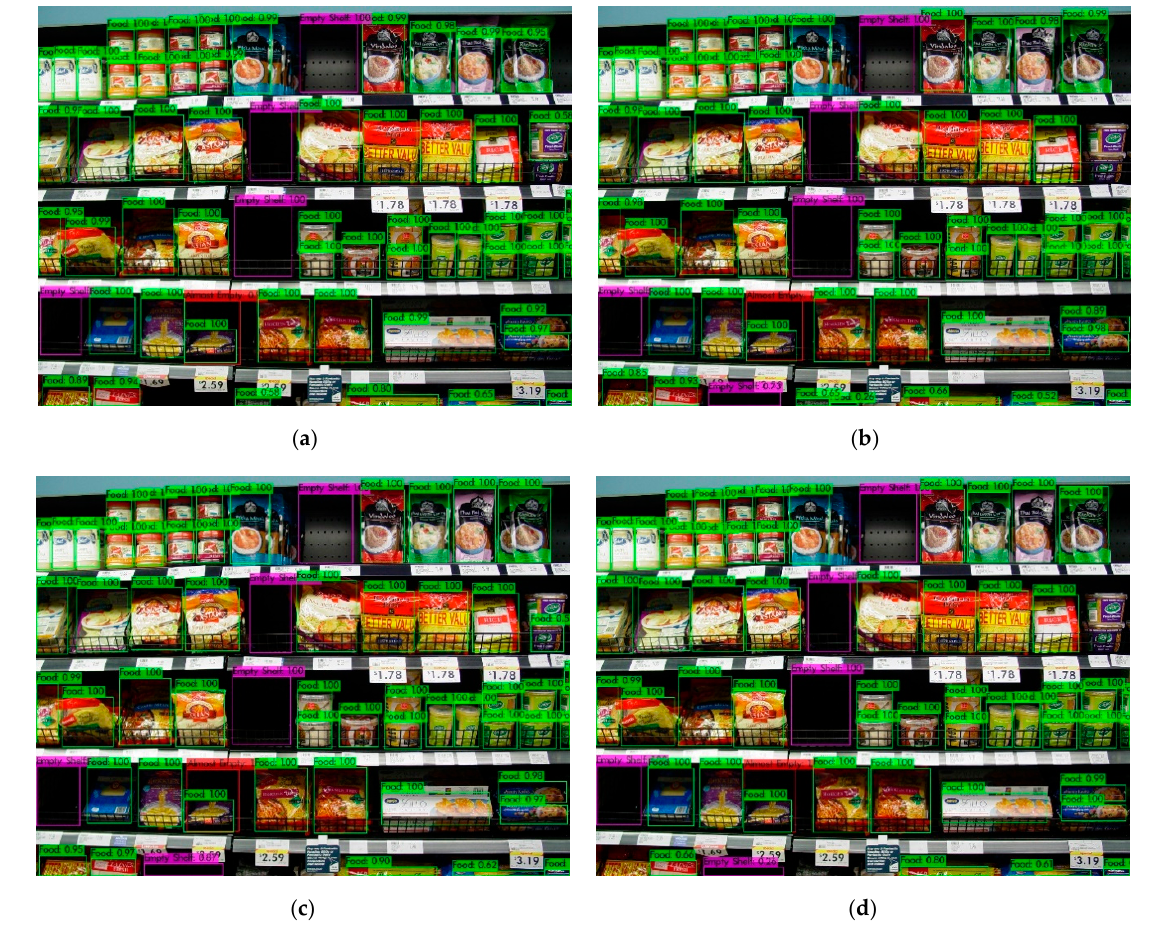
Figure 15. Sample object detection results of the rice and pasta section. It shows detection results using the model that was trained with ( a ) 20% of labeled images; ( b ) 40% of labeled images; ( c ) 60% of labeled images; and ( d ) 80% of labeled images.